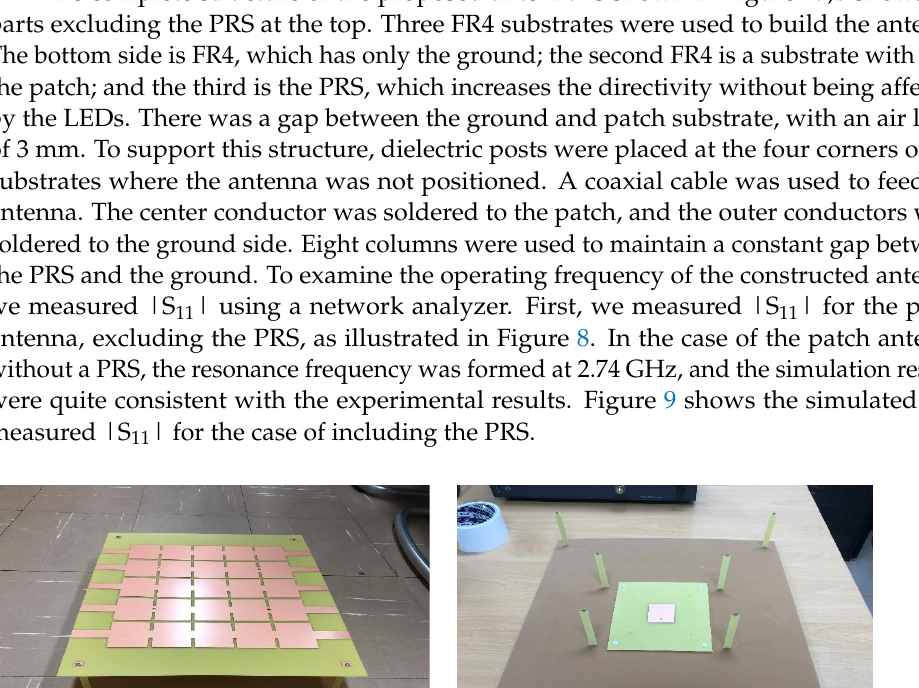
Figure 8. Simulated and measured |S 11 | of the patch antenna excluding a PRS. Figure 9. Simulated and measured |S 11 | of a Fabry-Perot cavity antenna. Even with the presence of a PRS, the simulation and measurement results were similar, and resonance was formed at 2.4 GHz. In the simulations, the impedance bandwidth of the antenna with |S 11 | < − 10 dB was 2.393–2.423 GHz (30 MHz); the